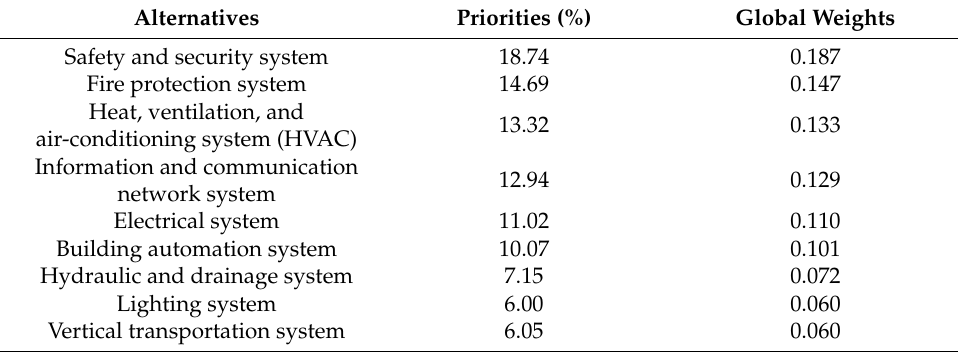
Table 3. Final weights of alternatives based on the AHP